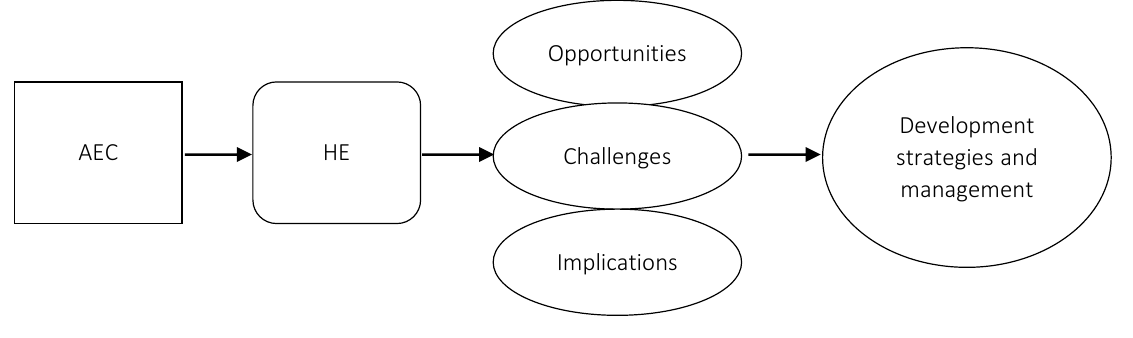
Figure 1. Framework of the